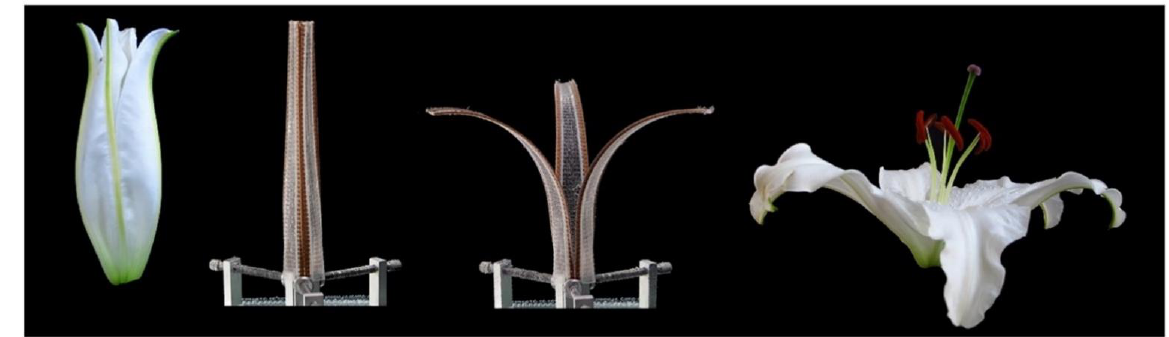
Figure 9. Moisture-induced deployable structure based on curved-line folding inspired by Aldrovanda, adapted from Le Duigou [175] with copyright permission of Elsevier.